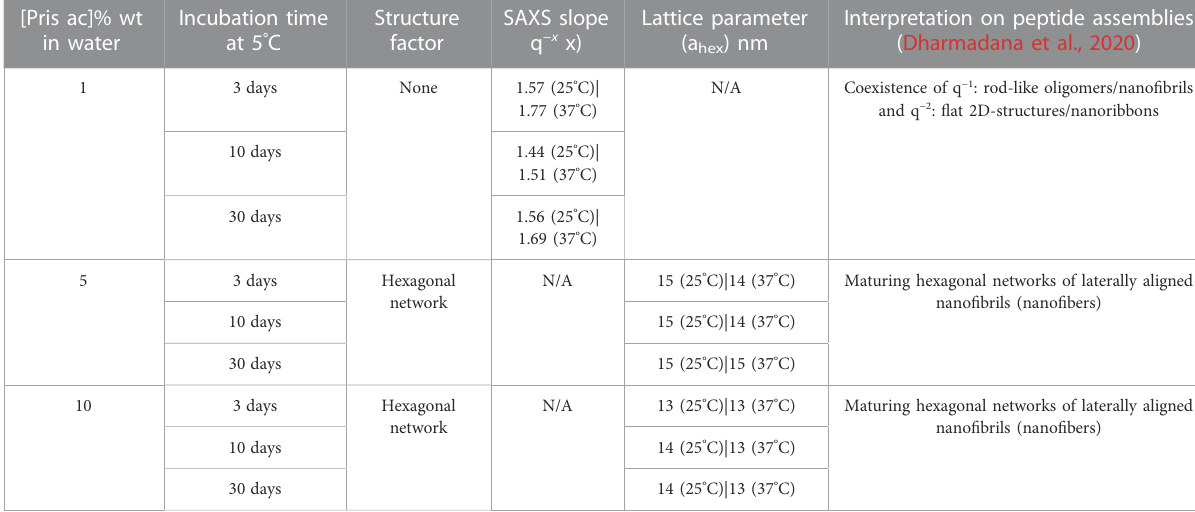
TABLE 4 Small angle X-ray scattering fi ts and assignments for Priscilicidin as a function of peptide acetate concentration in water, temperature, and incubation time. [Pris ac]% wt in water